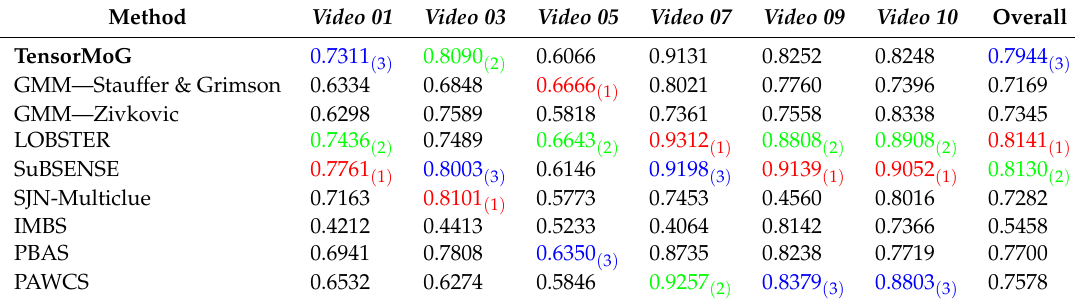
Table 4. F—measure comparisons the CAMO-UOW